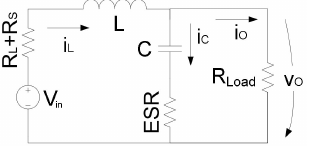
Figure 2. Buck converter circuit during the conduction